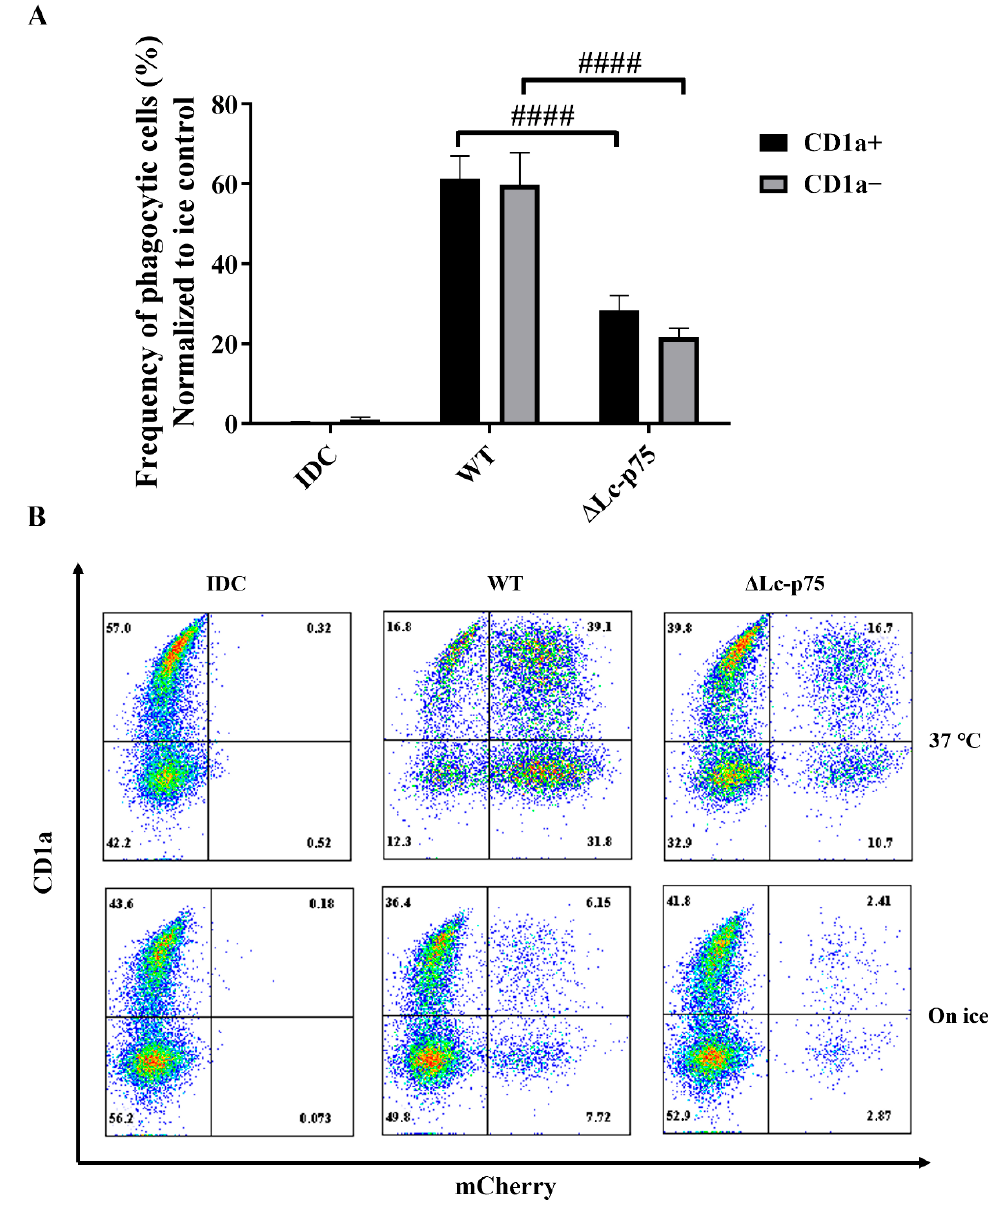
Figure 6. Phagocytic efficiency of moDCs activated with L. casei bacteria is independent of the CD1a expression. Five-day moDCs were stimulated with mCherry-labeled WT L. casei BL23 and ∆ Lc-p75 mutant bacteria for 24 h at 37 °C and on ice. The phagocytic capacity of CD1a + and CD1a − subsets was measured by detecting mCherry-positive moDCs with flow cytometry ( A ). IDC represents the sample without any bacterial treatment. The frequency of phagocytic cells was normalized to ice control, and the mean values of 3 independent experiments are presented ± SD. ( B ) Dot plots from one experiment showing the CD1a and mCherry expression of moDCs. Two-way ANOVA followed by Tukey’s multiple-comparison tests were used in the statistical analysis. Differences between WT and ∆ Lc-p75 were statistically significant, and defined as #### p < 0.0001. These observations indicated that the L. casei PGH’s targeted mutation modified the fate of the bacteria through the inhibition of their efficient uptake by phagocytic